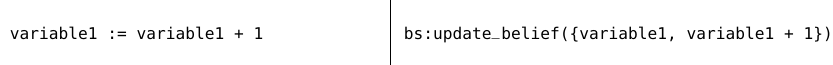
Table 8. TeleoR variable update (left). Erlang variable update (right).